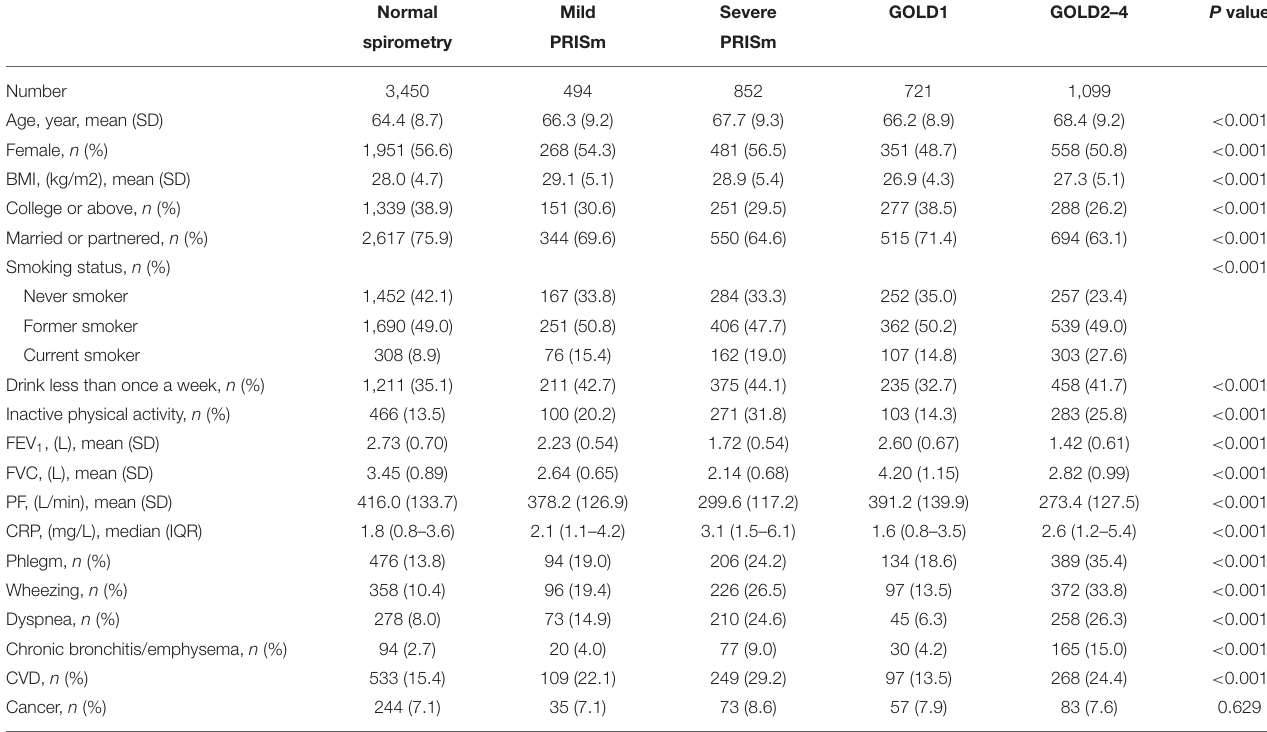
TABLE 1 | Baseline characteristics among subjects by the lung function categories. Normal